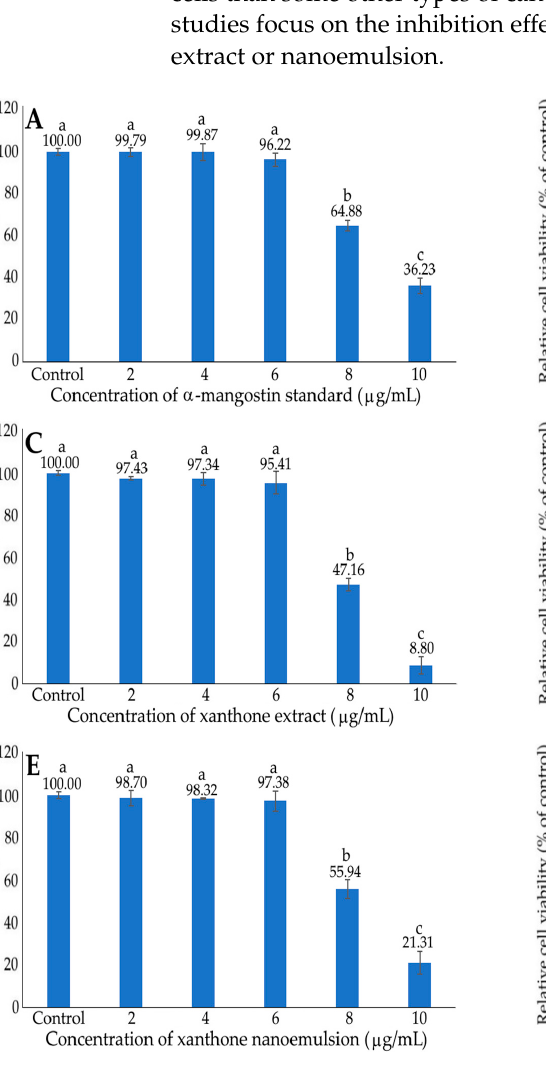
Figure 6. Effect of different concentrations of xanthone standard ( A , B ), extract ( C , D ) and nanoemul- sion ( E , F ) on the growth of liver normal cells AML12 ( A , C , E ) and liver cancer cells HepG2 ( B , D , F ) after 48 h incubation, as measured by MTT assay. Data shown are mean ± standard deviation (n = 3) and data with different small letters (a–e) are significantly different at p < 0.05.